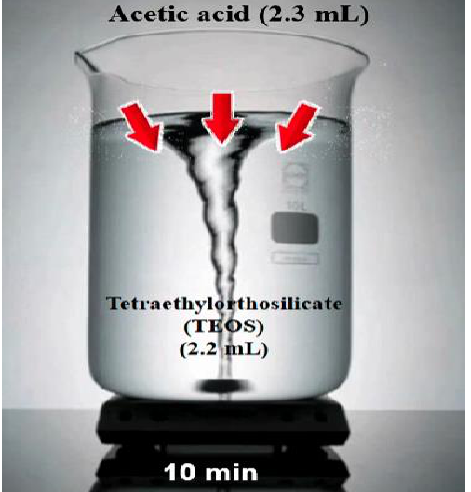
Figure 3. Adding 2.3 mL acetic acid to 2.2 mL Tetraethlorthosilicate (TEOS) and stirring for 10 min.